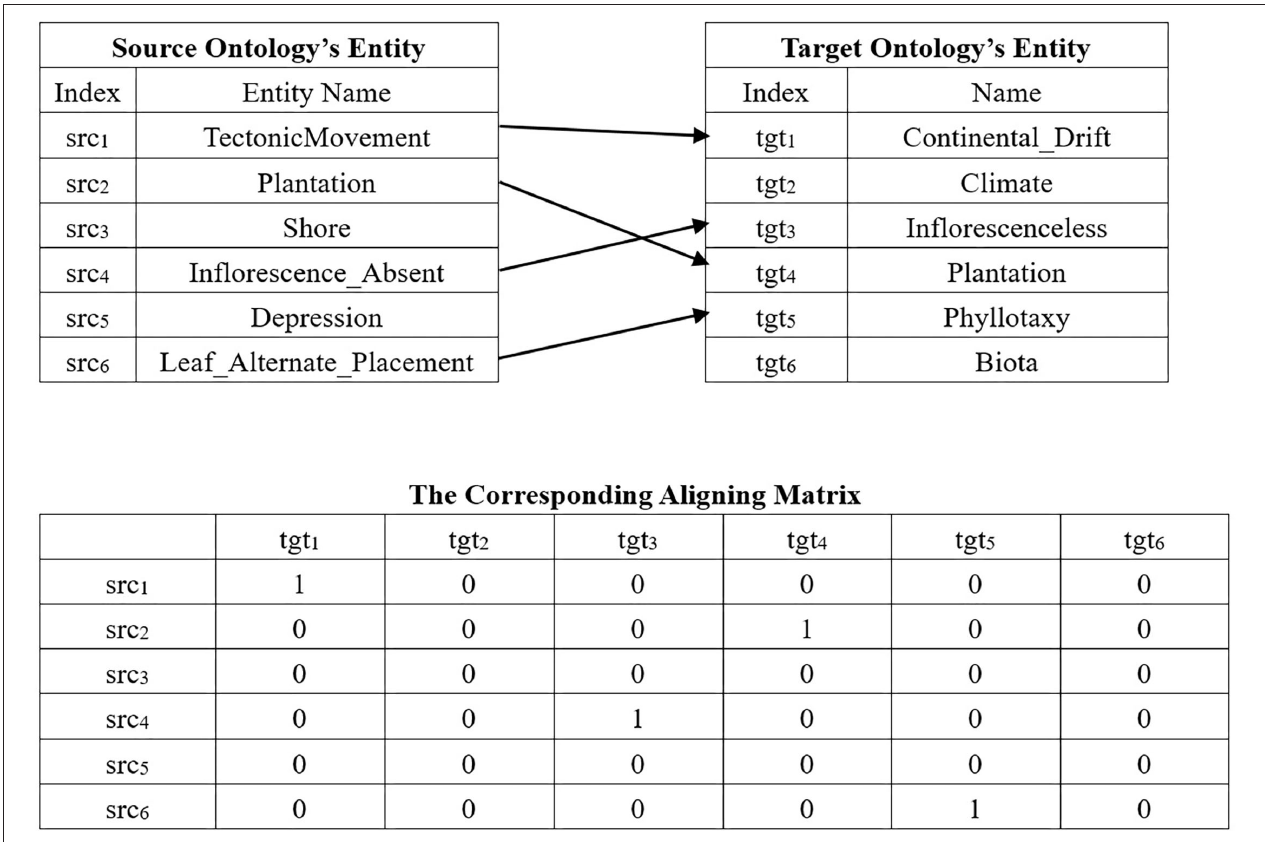
FIGURE 3 | An example of encoding